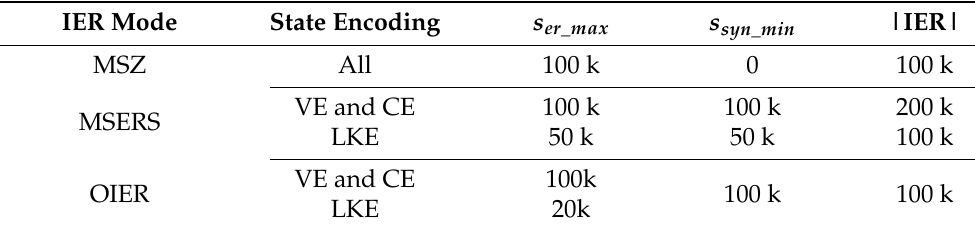
Table 4. The IER-related hyperparameter for the different IER modes.